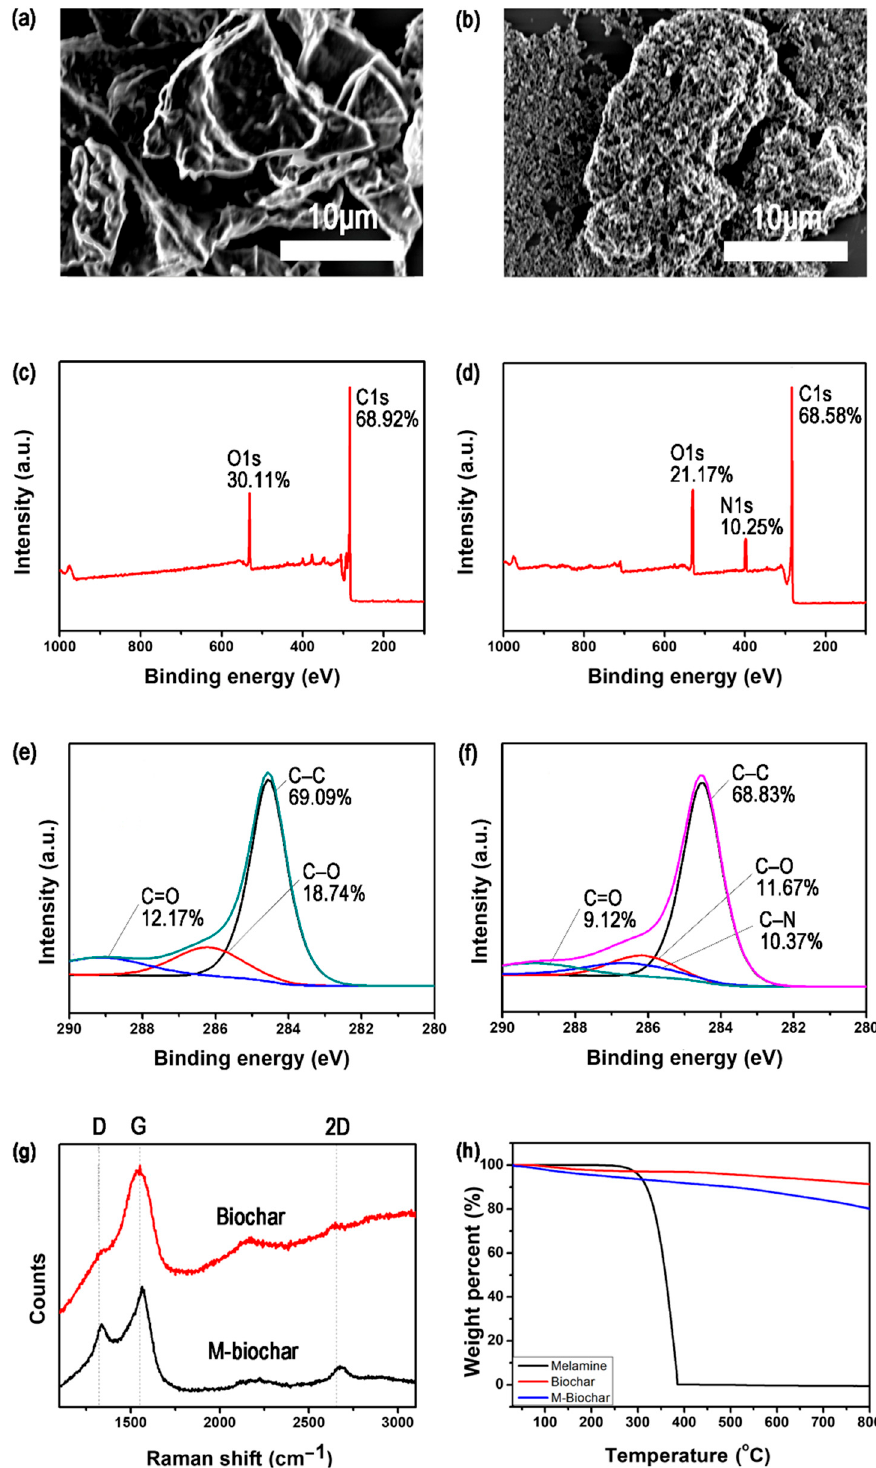
Figure 2. Functionalization of biochar: ( a ) SEM image of biochar and ( b ) m-biochar; ( c ) XPS survey of biochar and ( d ) m-biochar; ( e ) C1s spectra of biochar and ( f ) m-biochar; ( g ) Raman spectra of biochar and m-biochar; ( h ) TGA of melamine, biochar, and m-biochar. These functionalization processes facilitated the highly dispersive properties in the polar solvents, with the m-biochar exhibiting stable dispersive properties even after 24 h (Figure 3a). After 24 h, the 0.025 wt.% m-biochar dispersed in double distilled water (DDW) exhibited 100% of the absorption value at 550 nm, but 0.025 wt.% biochar